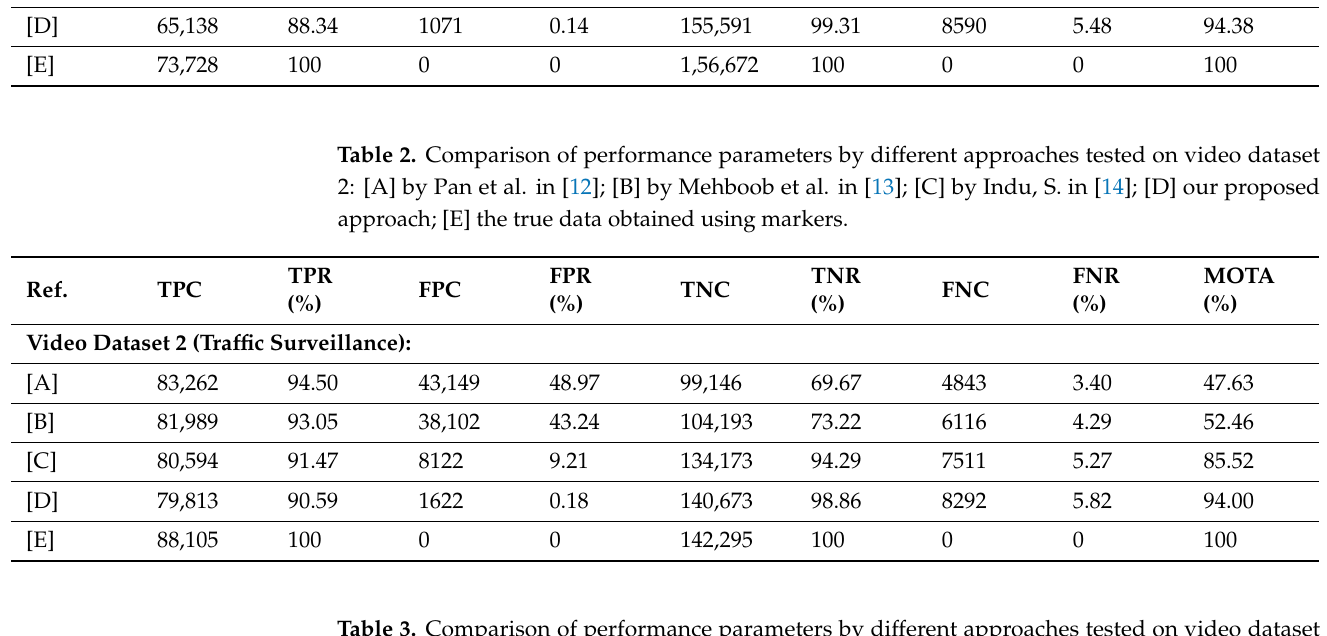
Table 3. Comparison of performance parameters by different approaches tested on video dataset 3: [A] by Pan et al. in [12]; [B] by Mehboob et al. in [13]; [C] by Indu, S. in [14]; [D] our proposed approach; [E] the true data obtained using